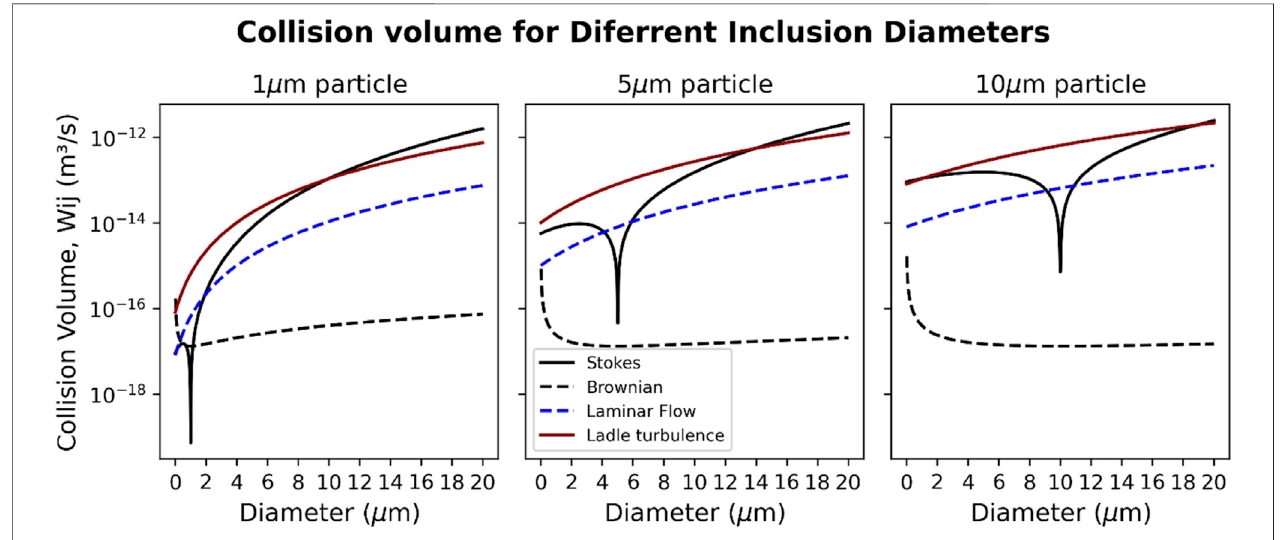
FIGURE 8 | Collision volumes for spherical inclusions (diameters 1, 5 and 10 µm), for different collision mechanisms.